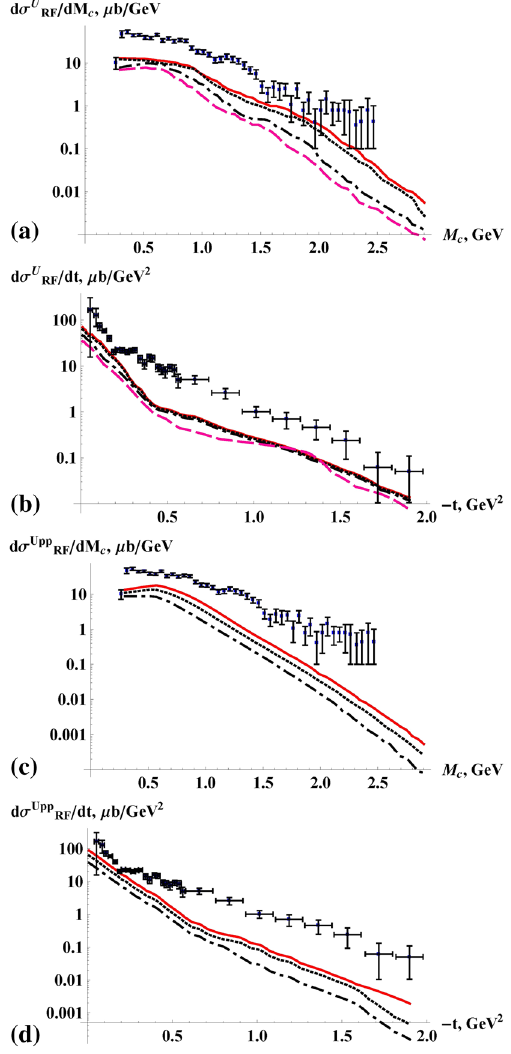
Fig. 9 RF case of the model (see Fig. 3) with all rescattering correc- tions ( a , b ) and also when we try to fit the data by formulas with- out final pion–proton rescattering ( c , d ). The data on the process √ p + p → p + π + + π − + p at s = 63 GeV, | y π | < 1, ξ p > 0 . 9, (ISR and ABCDHW collaborations [15,16]). Curves from up to down corre- spond to different values of the parameter Λ π in the off-shell pion form factor (11): a , b Λ π = 4 , 3 , 1 . 6 , 1 . 2 GeV, c , d Λ π = 1 . 2 , 1 , 0 . 8 Fig. 8 PB case of the model (see Fig. 3). The data on the process p + √ p → p + π + + π − + p at s = 200 GeV, | η π | < 1, | η ππ | < 2, p T π > 0 . 15 GeV, 0 . 005 < − t 1 , 2 < 0 . 03 GeV 2 , (STAR collaboration [17,18]). a , b show the result with all p p and π p rescattering corrections, c , d show the result when we try to fit the data by formulae without π p rescattering terms. Curves from up to down correspond to different values of the parameter Λ π in the off-shell pion form factor (11): a , b Λ π = 0 . 45 , 0 . 43 , 0 . 41 , 0 . 4 GeV, c , d Λ π = 0 . 43 , 0 . 4 , 0 . 37 , 0 . 35 GeV